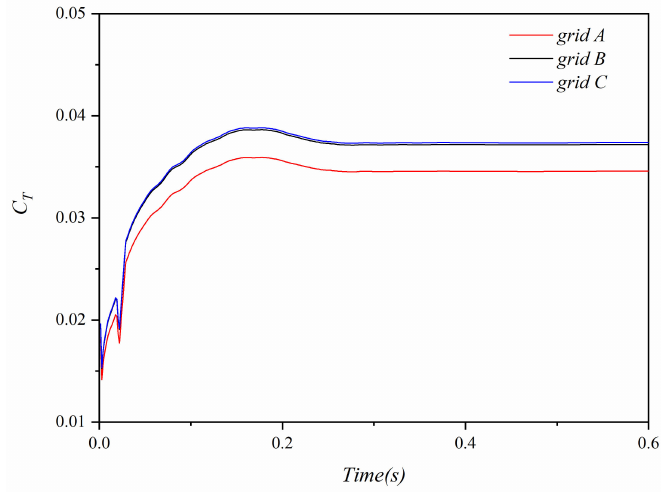
Figure 5. Rotor thrust coefficients with different